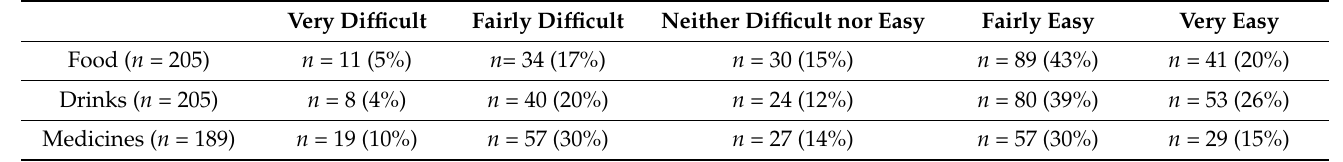
Table 4. Perceived ease of label checking by product